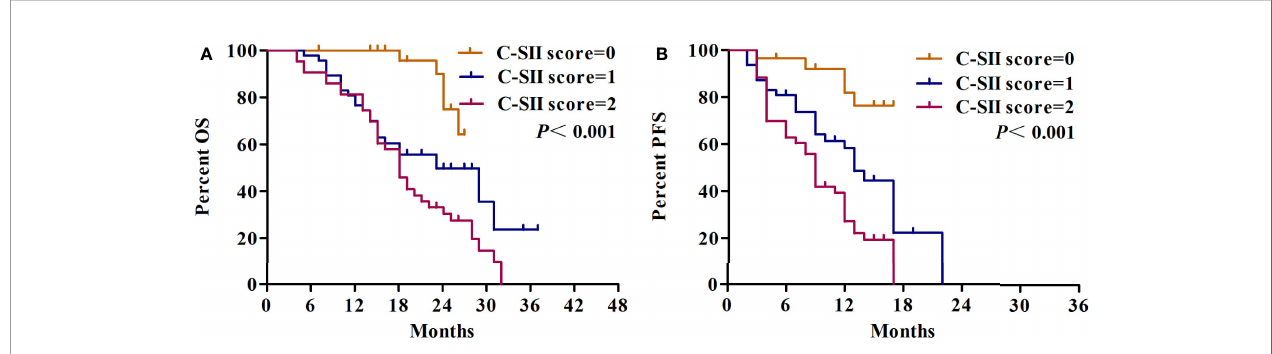
FIGURE 7 | Kaplan – Meier survival curves depicting outcomes of overall survival (A) and progression-free survival (B) according to the C-SII